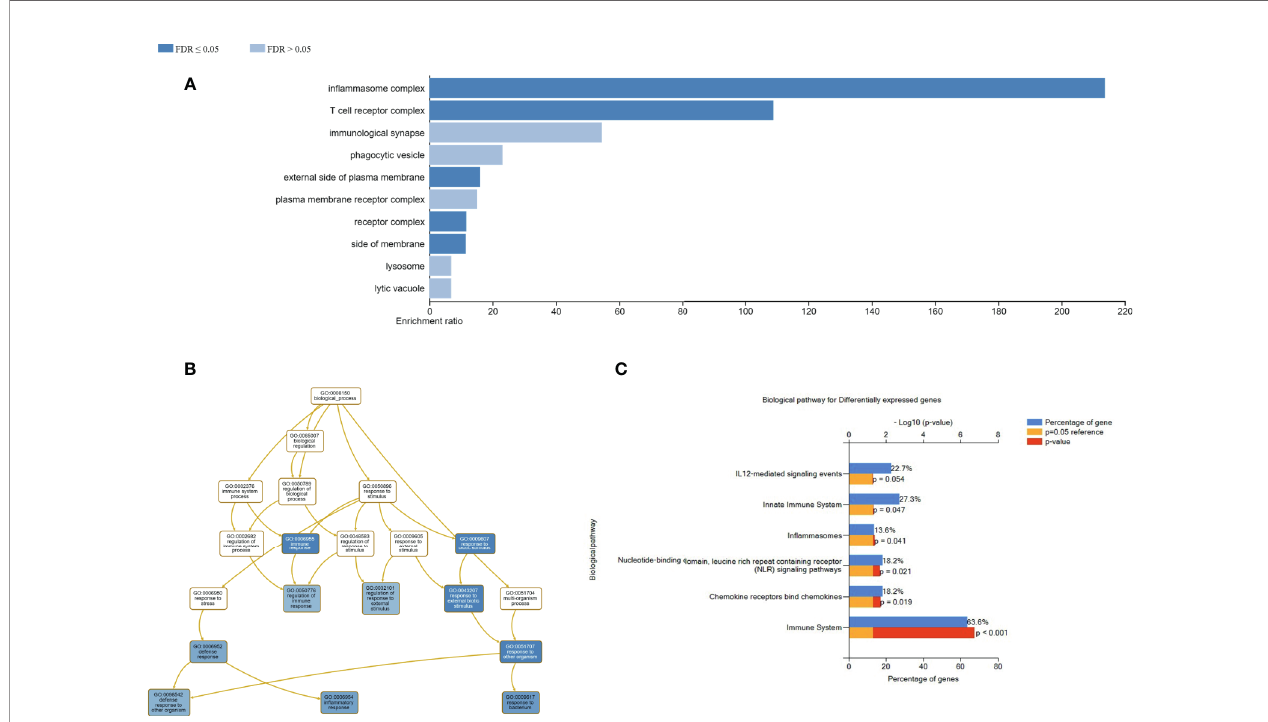
FIGURE 5 | Improved visualizations on the result page of WebGestalt. (A) Bar chart shows enrichment ratio or normalized enrichment score of results with direction. (B) Directed acyclic graph representation with colored nodes depicting corresponding biological process of the enriched genes in the input gene set. Functional enrichment analysis of genes using FunRich. (C) Bar graph of biological pathways in percentage of genes are shown; the blue bar represents the percentage of genes, the yellow bar represents the reference p-value=0.05 and the red bar that depicts the exact